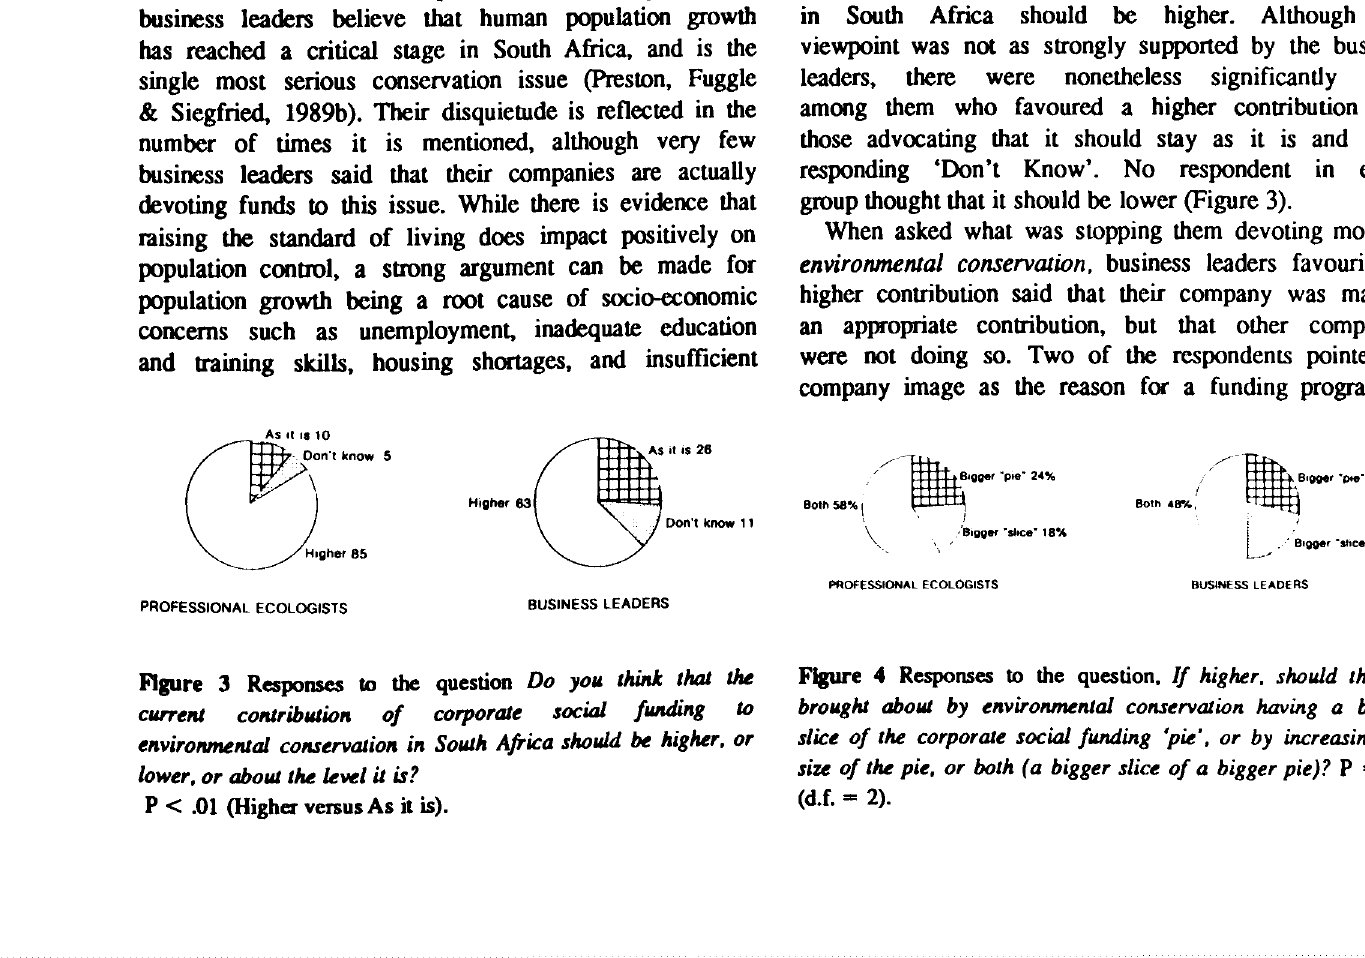
Figure 4 Responses to the question, If higher, should this be brought about by environmental conservation having a bigger slice of the corporaJe social funding 'pie', or by increasing the siu of the pie, or both (a bigger slice of a bigger pie)? P = .40 (d.f. =